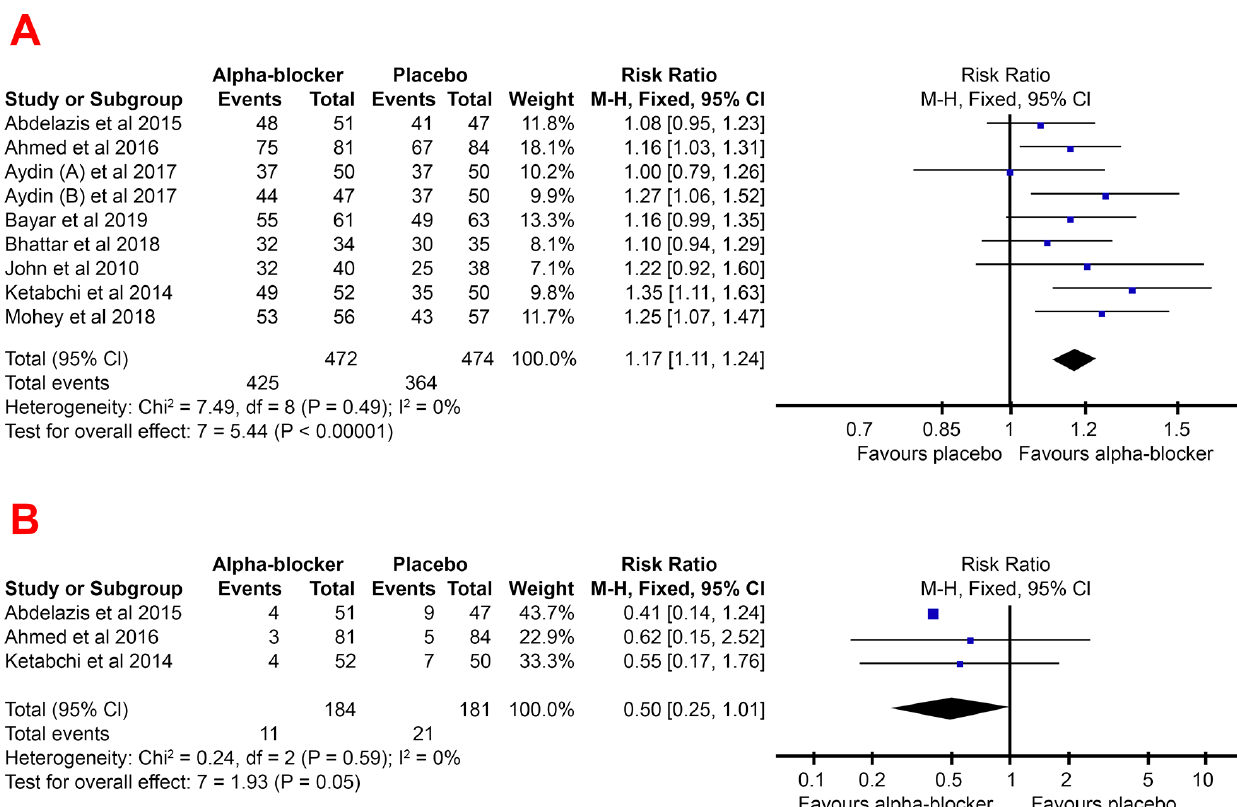
Figure 3. Forest plot of stone free rate ( A ) and readmission ( B ) pooled RR for the group treated with alpha-blocker compared to group treated with placebo -blocker compared to control group. The lower risk of readmissions due to initial URS failure also supported a higher stone-free rate in the alpha-blocker group. The risk of readmission to URS in the alpha-blocker group tends to be lower than the placebo group, with a pooled RR of 0.50 (95% CI,